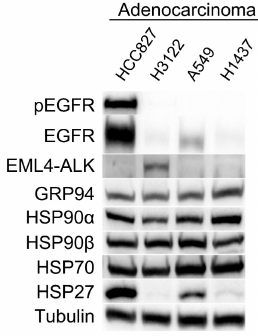
Figure 1. Characterization of a panel of adenocarcinoma cell lines. Western blot analysis of adenocarcinoma cell lines whose oncodrivers are either directly (epidermal growth factor receptor (EGFR) in HCC827 and EML4-ALK in H3122 cell lines) or indirectly Kirsten rat sarcoma (KRAS) viral oncogene homolog) in the A549 cell line) related to HSP90, as well as an EGFR, anaplastic lymphoma kinase (ALK) and KRAS wild-type cell line (H1437). This technique was employed to study protein expression levels of constitutive and inducible HSP90, other related heat shock proteins (HSPs)